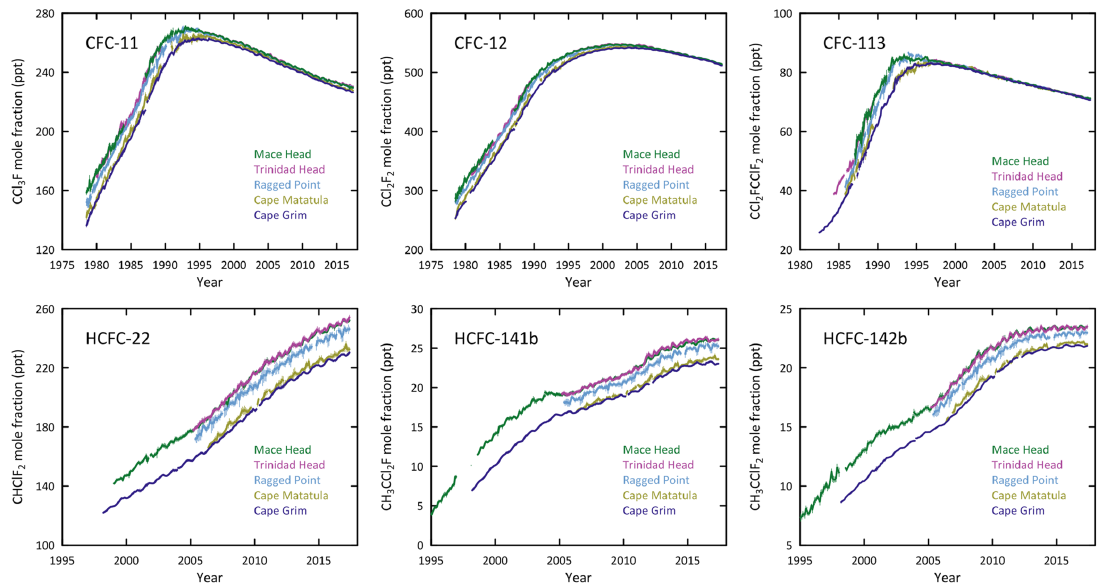
Figure 3. Monthly mean mole fractions (ppt) and their standard deviations (vertical bars) for selected AGAGE Montreal Protocol gases through